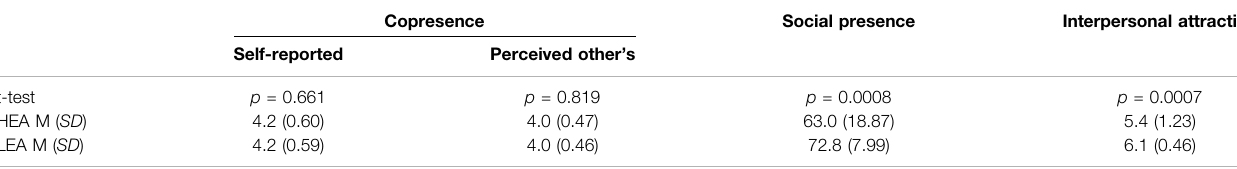
TABLE 2 | Statistical results for copresence, social presence, and interpersonal attraction.